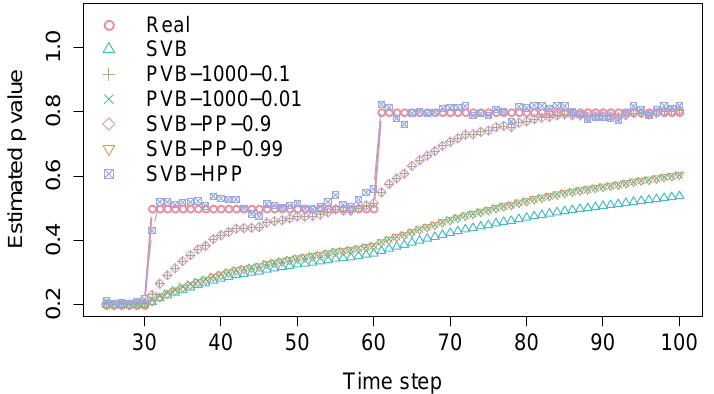
Figure 5. E [ β t ] in the beta-binomial model artificial data set: note that PVB-1000-0.1 overlaps with SVB-PP-0.9 and PVB-1000-0.01 overlaps with SVB-PP-0.99. The exact value is denoted with red circles.